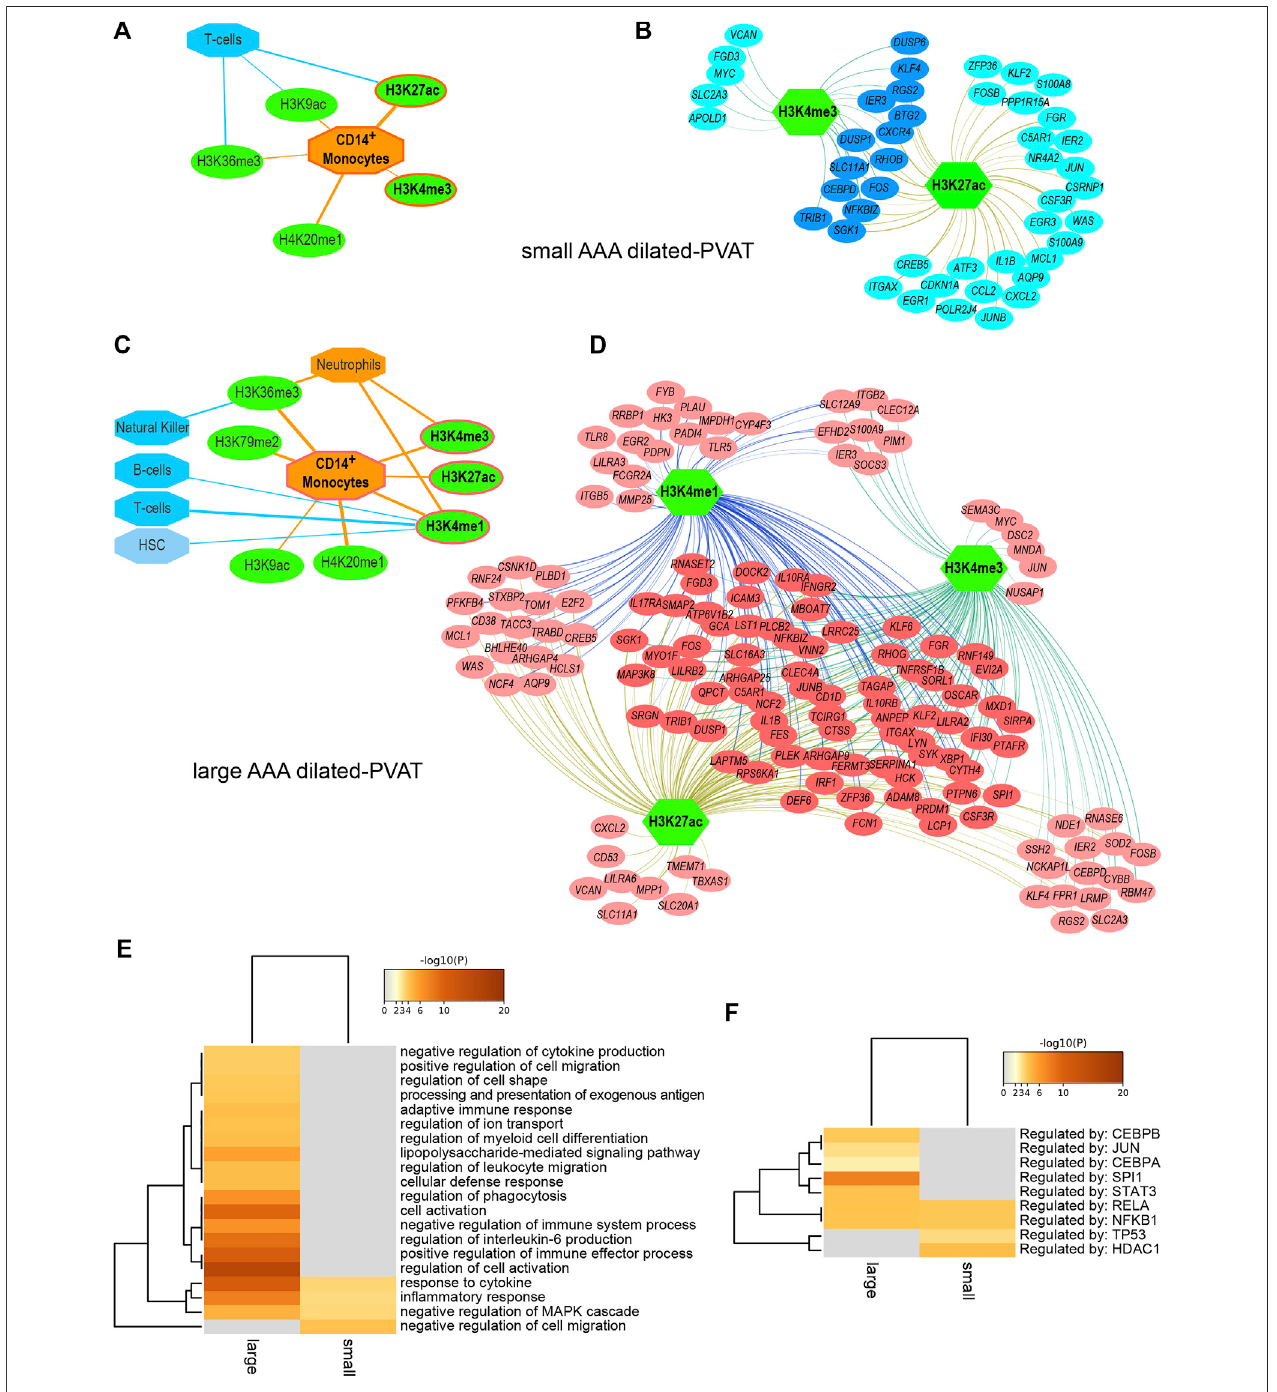
FIGURE 1 | Regulatory networks and functional enrichment analysis of genes overexpressed in AAA dilated-PVAT related to immune cells and functions (A) Predicted histone modi fi cations (green ovals) signi fi cantly associated with transcriptionally active euchromatin of myeloid or lymphoid immune cells (orange and blue octagons,respectively)insmallAAAdilated-PVAT.Thehistonemarksignaturerecallingimmuneresponseafteracutestimulationishighlightedwithanorangeborder. In thisandpanelC,edgethicknessisproportionaltothenormalizedenrichmentscore,whichmeasurestherelevanceofenrichment (B) Regulatorynetworkofhistone marks and genes overexpressed in dilated-PVAT linked to acute stimulation in early-stage AAA (small AAA). Green hexagons represent histone marks associated with CD14 + monocytes, blue ovals show associated genes. Overexpressed genes associated with this histone mark signature are highlighted in dark blue (C) Predicted histone modi fi cations signi fi cantly associated with myeloid or lymphoid immune cells in large AAA dilated-PVAT. The histone mark signature recallingtrained immunity is outlined in orange (D) Regulatory network of histone marks and genes overexpressed in dilated-PVAT linked to trained immunity in advanced AAA (large AAA). Green